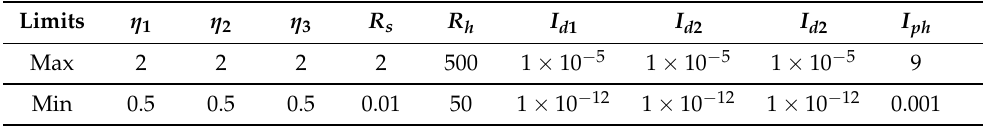
Table 2. Minimum and maximum limits to evaluate the Kyocera KC200GT and Suntech STP245S PV